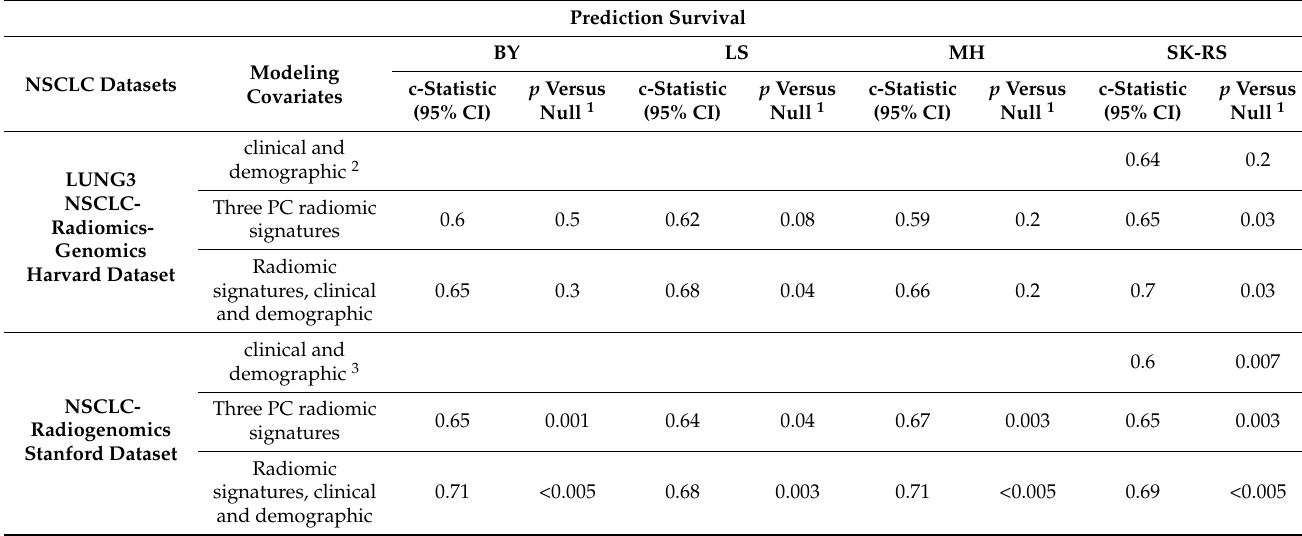
Table 4. Overall survival, Cox regression. Using the low-rank representation of the radiomic signatures survival prediction is measured for each segmenter.